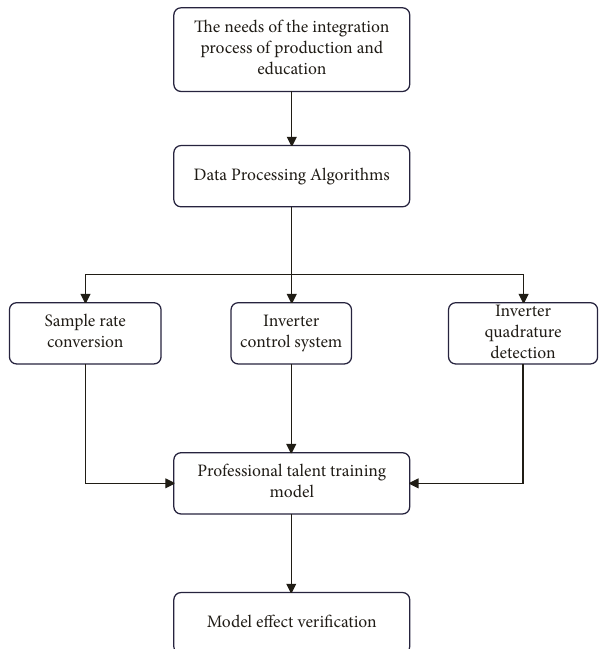
Figure 1: Research